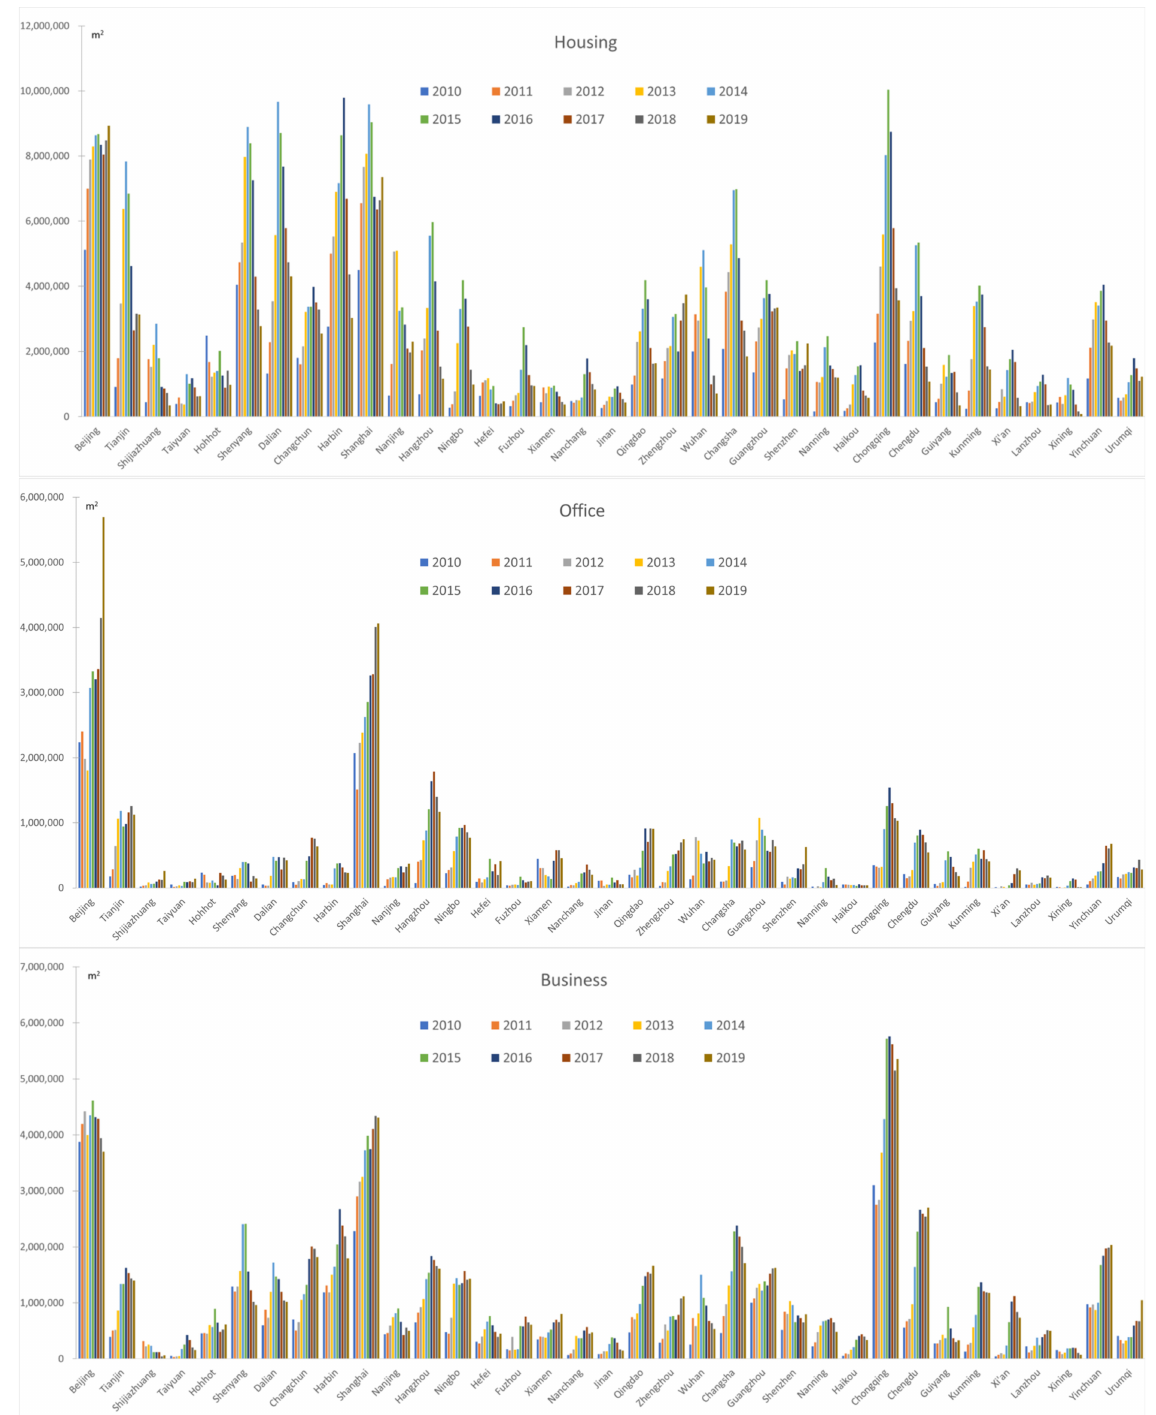
Figure 4. Analysis of real estate inventory change from 2010 to 2019 in the 35 key